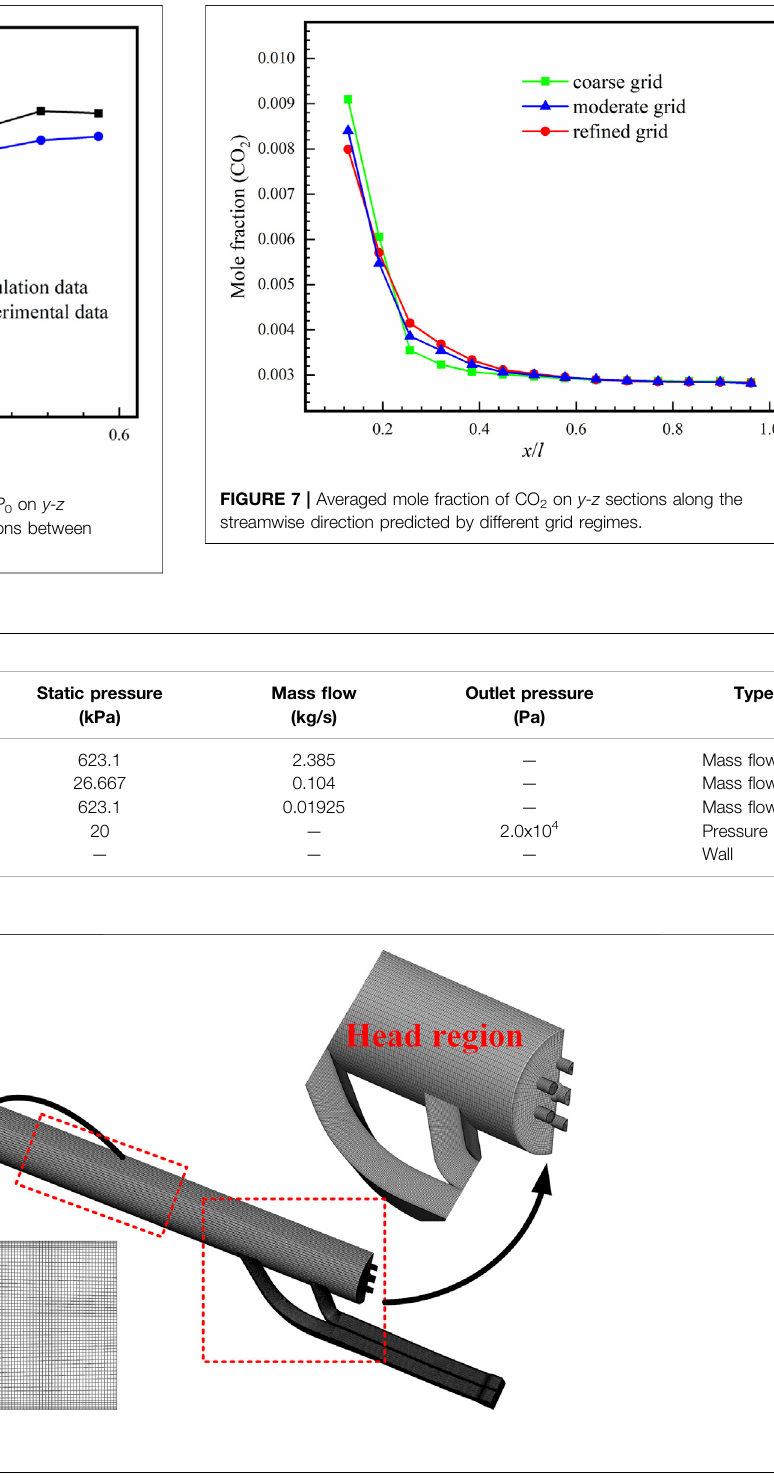
From Figure 7 , the calculated carbon dioxide concentration on the cross section by three grid systems is basically overlapping.